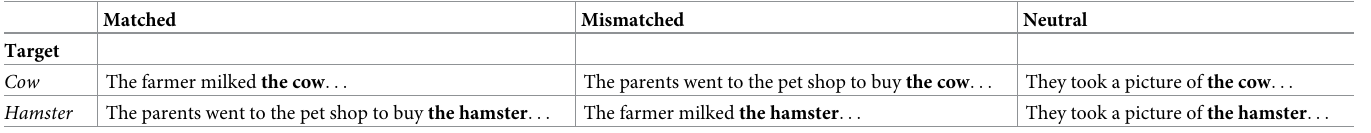
Table 1. Example of a sentence pair. Half of the participants would see the three sentences with “cow” and the other half would see the three sentences with “hamster”. A given sentence formed a matched context for one target and a mismatched context for the other target. Sentences never ended with the target word, but for simplicity, we removed the sentence endings from these examples. Matched Mismatched Neutral Target Cow The farmer milked the cow ... The parents went to the pet shop to buy the cow ... They took a picture of the cow ... Hamster The parents went to the pet shop to buy the hamster ... The farmer milked the hamster ... They took a picture of the hamster